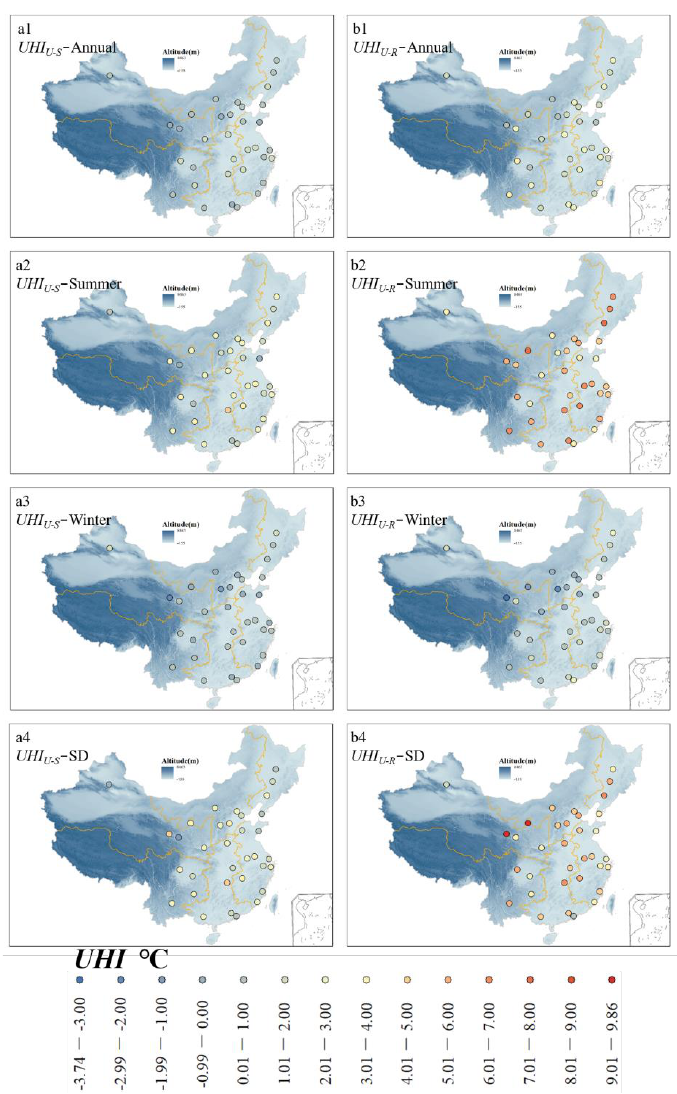
Figure 5. Spatial distributions of average 𝑈𝐻𝐼 𝑈−𝑆 and 𝑈𝐻𝐼 𝑈−𝑅 from 2001 to 2020 for 34 cities (unit: °C): annual ( a1 ) 𝑈𝐻𝐼 𝑈−𝑆 and ( b1 ) 𝑈𝐻𝐼 𝑈−𝑅 , summertime ( a2 ) 𝑈𝐻𝐼 𝑈−𝑆 and ( b2 ) 𝑈𝐻𝐼 𝑈−𝑅 , wintertime ( a3 ) 𝑈𝐻𝐼 𝑈−𝑆 and ( b3 ) 𝑈𝐻𝐼 𝑈−𝑅 , and seasonal differences (SDs) in ( a4 ) 𝑈𝐻𝐼 𝑈−𝑆 and ( b4 ) 𝑈𝐻𝐼 𝑈−𝑅 . SD is defined as the 𝑈𝐻𝐼 difference between summer and winter. Topography, land-cover type, and meteorological conditions can affect the urban 𝐿𝑆𝑇 , altering the 𝑈𝐻𝐼 [43,63]. Figure 6a shows 𝑈𝐻𝐼 𝑈−𝑆 and 𝑈𝐻𝐼 𝑈−𝑅 for different topog- raphies. Annual and summertime 𝑈𝐻𝐼 𝑈−𝑅 show similar patterns: the 𝑈𝐻𝐼 𝑈−𝑅 of coastal cities was smaller than that of inland cities because sea breezes driving cold air into urban areas greatly reduced the 𝑈𝐻𝐼 in summer [64,65]. However, in winter, the 𝑈𝐻𝐼 𝑈−𝑅 of coastal cities was larger than that of inland cities, probably because land breezes